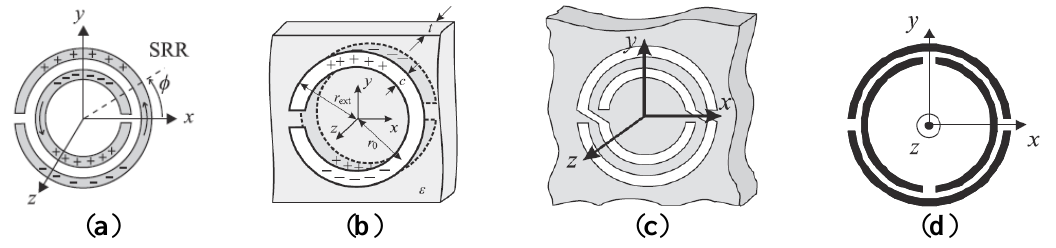
Figure 4. Topology and charge distribution of ( a ) conventional SRR, ( b ) broadside coupled split ring resonators (BC-SRR), ( c ) non-bianisotropic split ring resonator